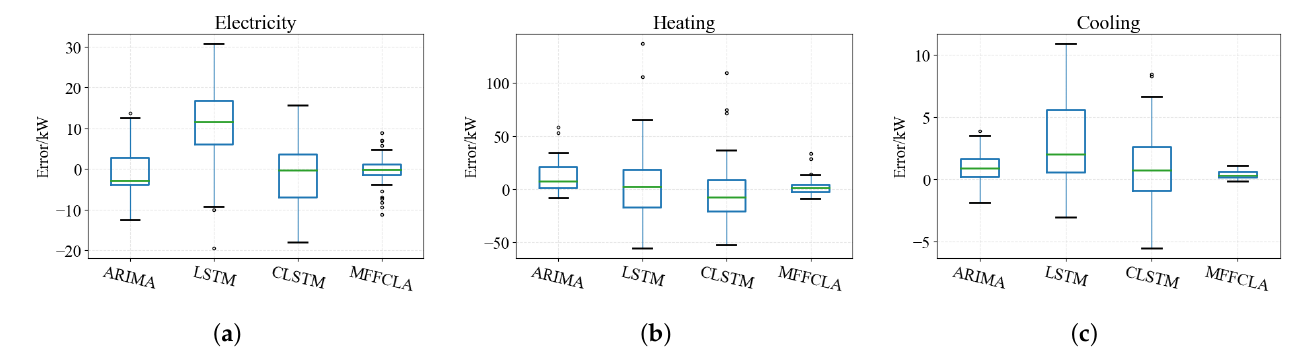
Figure 11. Multi-energy load forecasting error box diagram. ( a ) The boxes of electricity load forecast- ing results of each model. ( b ) The boxes of heating load forecasting results of each model. ( c ) The boxes of cooling load forecasting results of each